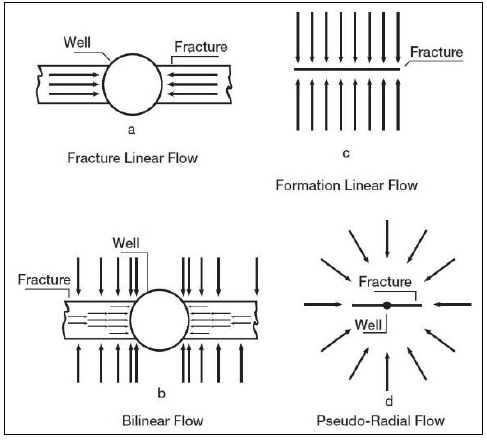
Figure 3. Flow regimes after Cinco et al. [28] (p.